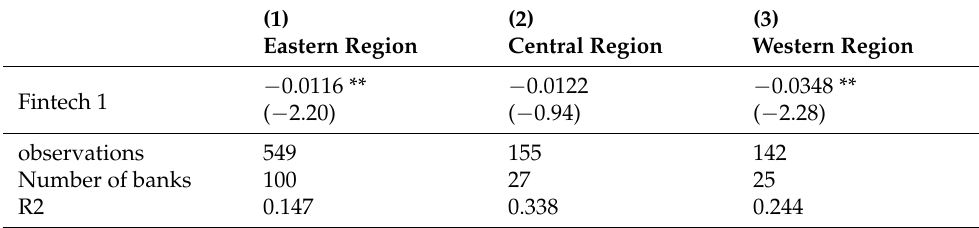
Table 9. Test results of differences in the eastern, western and central parts of China. (1)